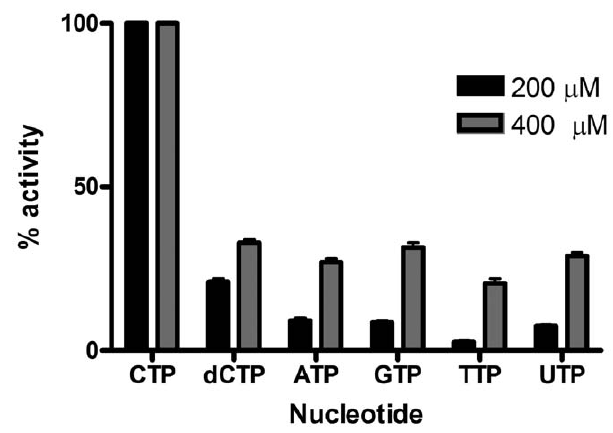
Figure 5. The nucleotide specificity of F. tularensis MEP cytidylyltransferase. Enzyme assays were performed with the identified nucleotide at either 200 m M or 400 m M, as indicated. The assays contained a fixed MEP (200 m M) concentration. Each assay was performed in duplicate. Relative enzyme activity reveals the preference of the enzyme for